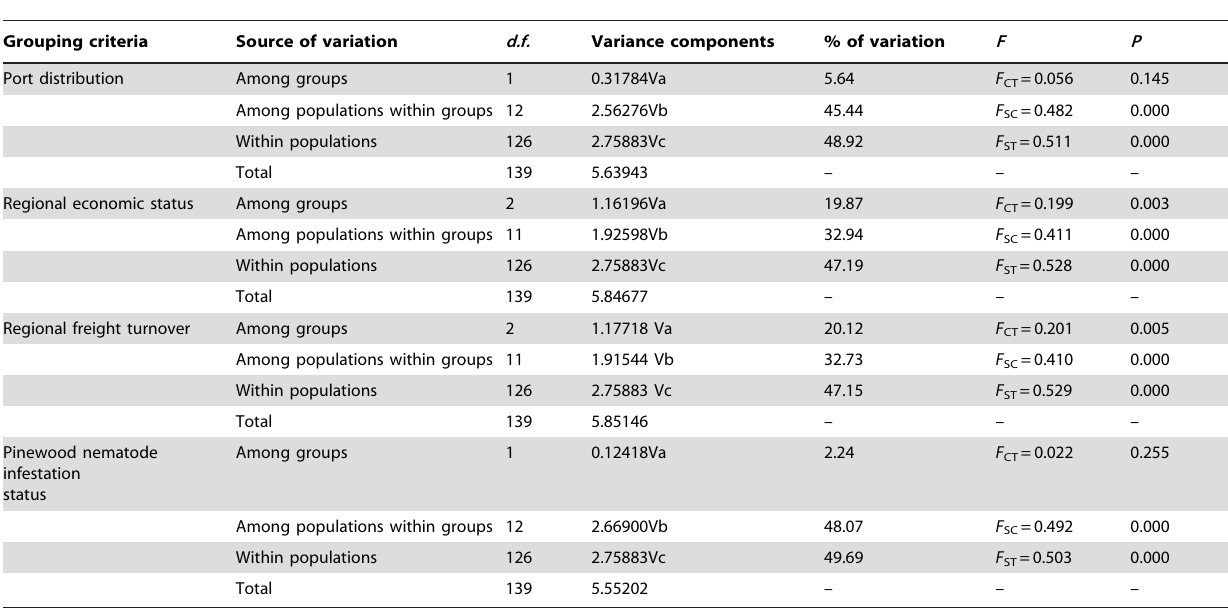
Table 3. Summary results for AMOVA analyses of the 14 populations of M. alternatus from China that were compared using three grouping criteria (see details in Table 1).